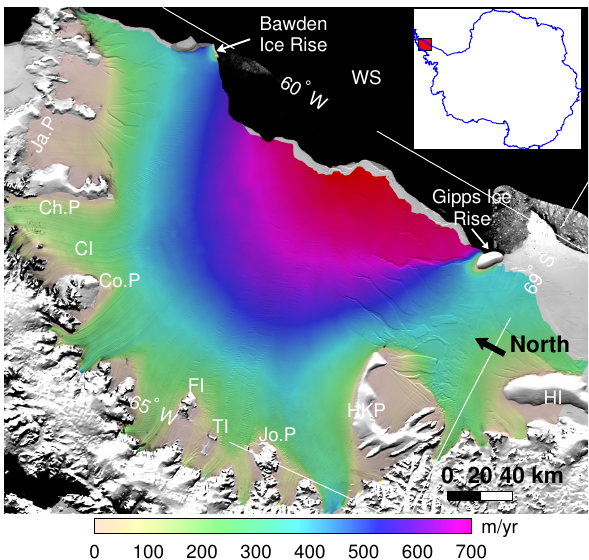
Fig. 1. Magnitude of horizontal surface velocity from InSAR data for period 2006–2009, overlaid on a 2009 MODIS Mosaic of Antarctica (MOA) image (http://nsidc.org/data/moa/). Inset shows location of the ice shelf on the Antarctic Peninsula. Place name acronyms are Ja.P = Jason Peninsula, Ch.P = Churchill Penin- sula, CI = Cabinet Inlet, Co.P = Cole Peninsula, FI = Francis Is- land, TI = Tonkin Island, Jo.P = Joerg Peninsula, HKP = Hollick– Kenyon Peninsula, HI = Hearst Island, WS = Weddell